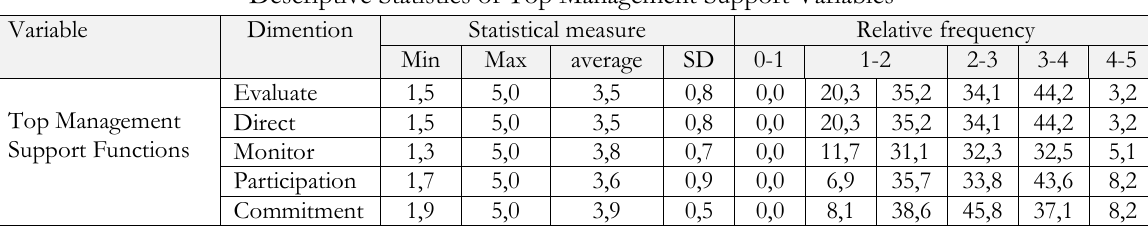
Descriptive Statistics of Top Management Support